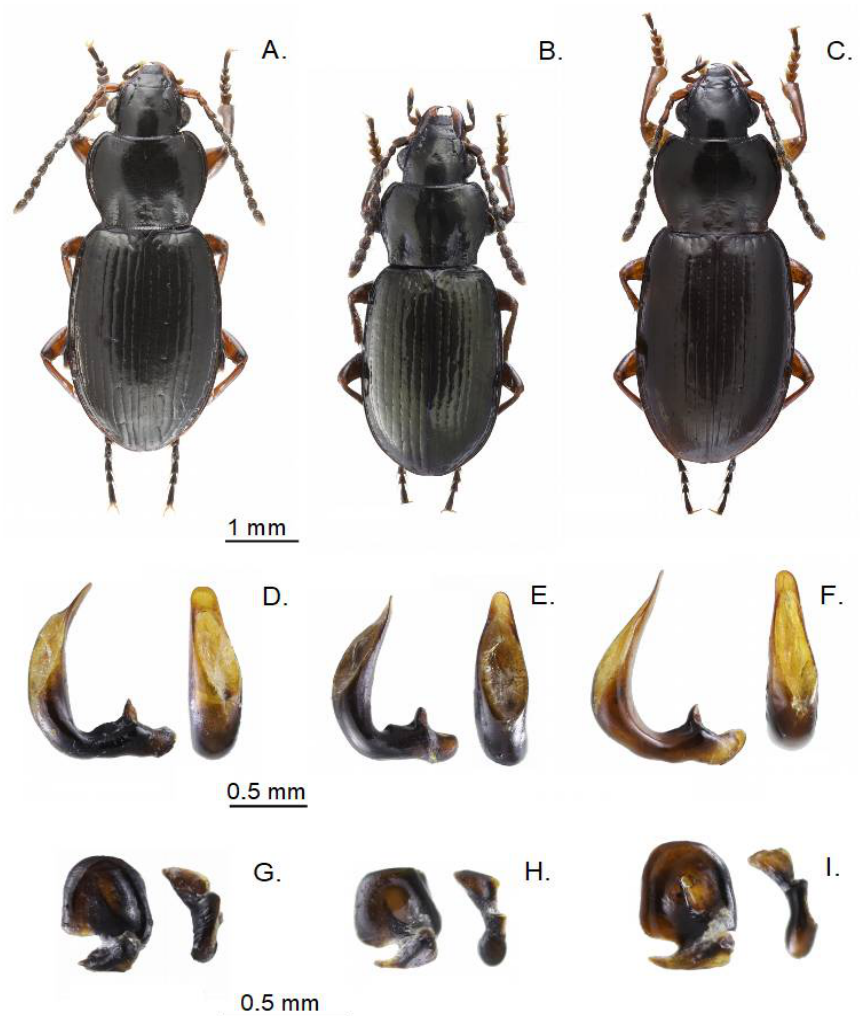
Figure 2. Habitus and male genitalia of P. b. brevicornis ( A , D , G ), P. nivalis ( B , E , H ), and P. mandibu- laroides ( C , F , I ). ( A – C ) Habitus; ( D – F ) median lobe in left lateral and ventral aspect, apical portion; ( G – I ) left and right parameres.